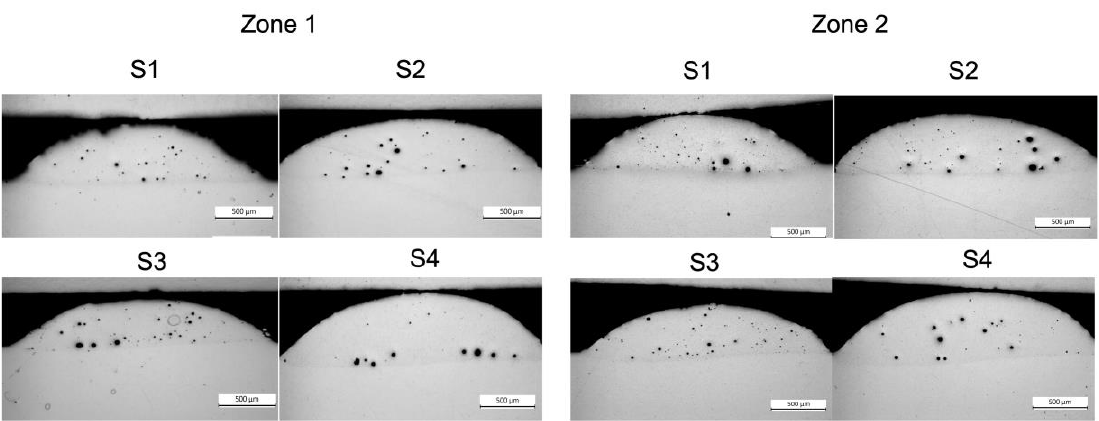
Figure 5. Unetched representative micrographs of the cross sections of track A for the four sets of parameters (S1 – S4) in the two different zones (Zone 1, Zone 2).